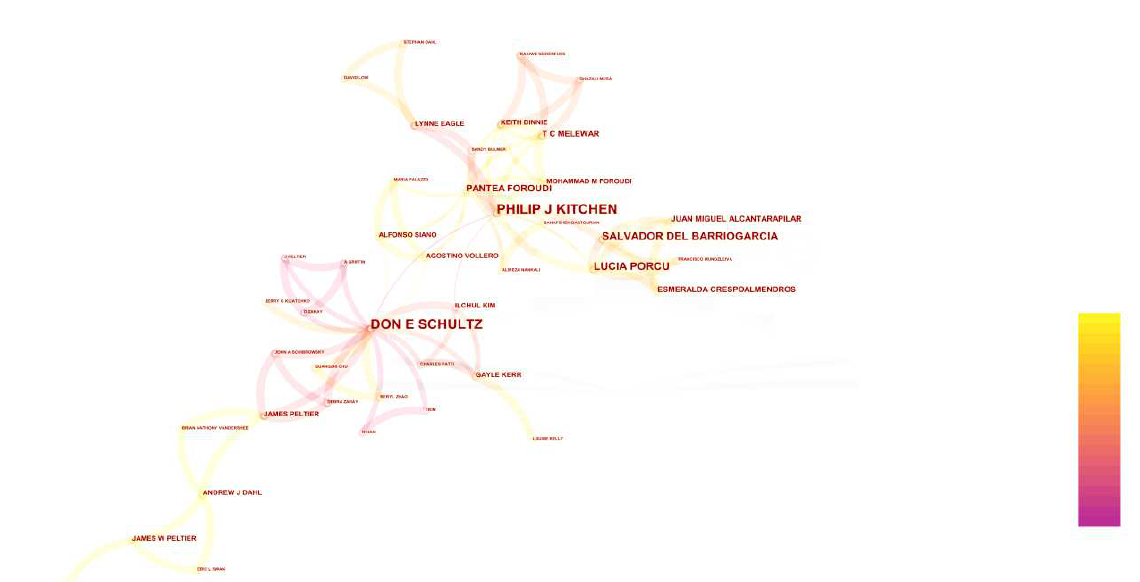
Figure 5. Author co-occurrence map (WoS